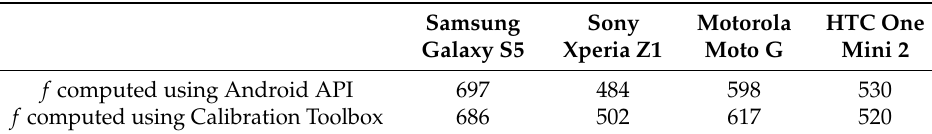
Table 1. Focal distance calibration